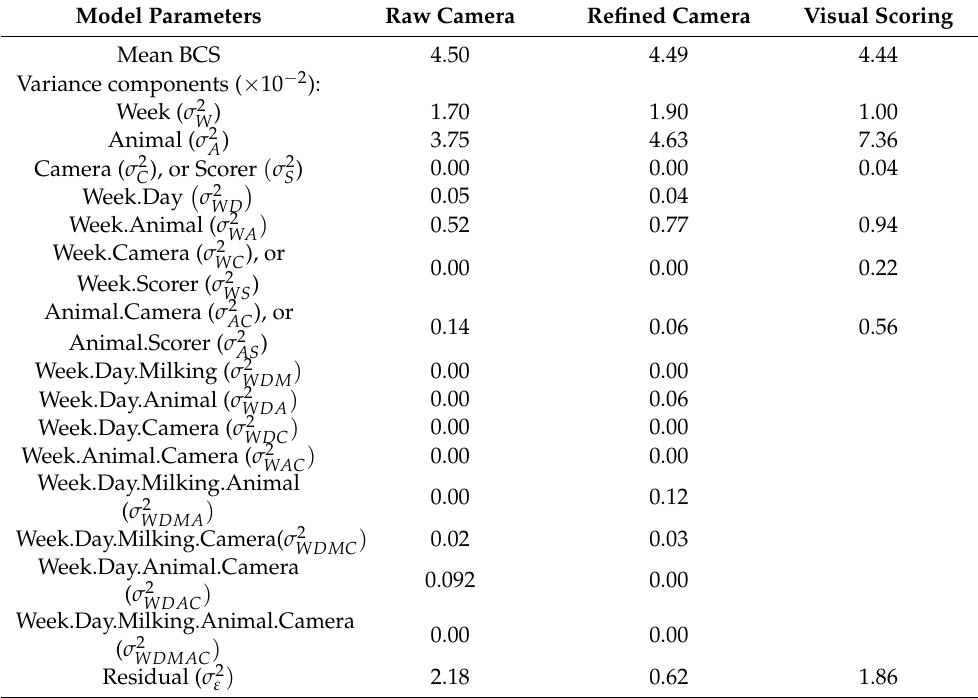
Table 1. Estimates of random-effect model parameters (mean and variance components) for each of raw camera, refined camera, and visual body condition score (BCS) data. Camera measurements were taken at least twice daily for a period of 7 weeks on each of 32 cows. The same cows were scored visually for BCS by three scorers on one day of each week over the same period. Model Parameters Raw Camera Refined Camera Visual